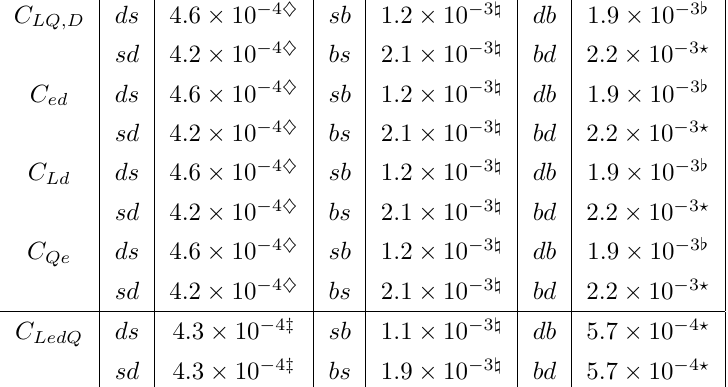
, or B meson decay modes ( ? ) S